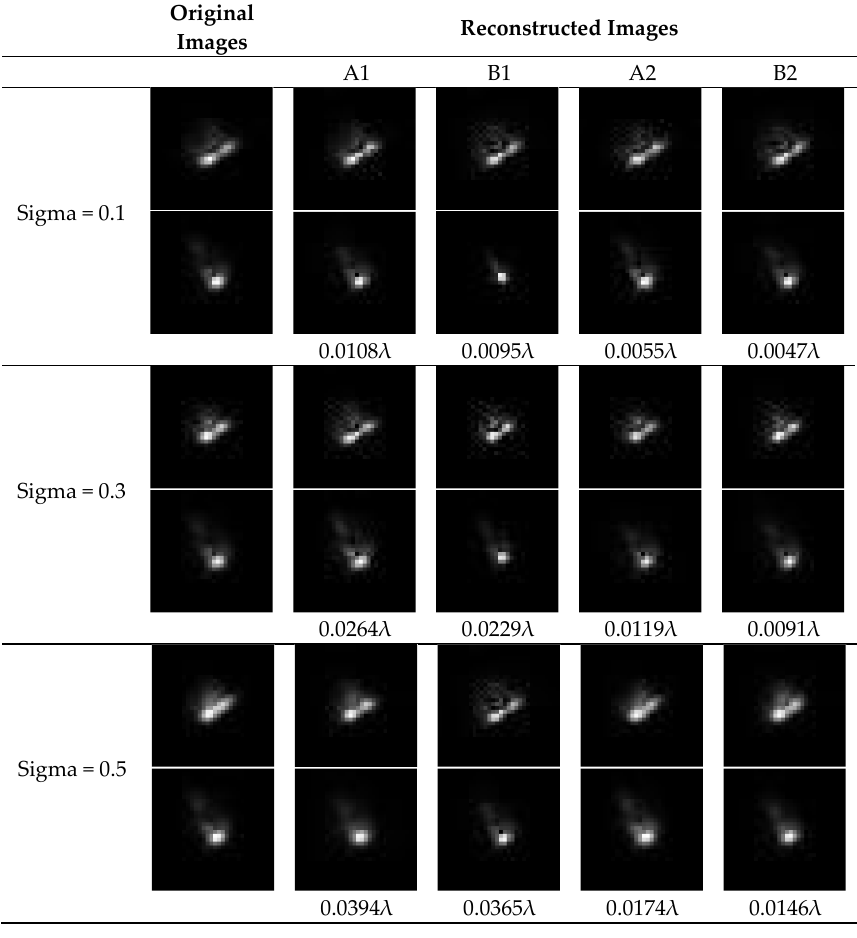
Figure 8. Results of the Traditional phase retrieval algorithms (A1, B1) and the jitter-robust phase retrieval algorithms (A2, B2) when they are applied to those images obtained in the experiment which include the effects of jitter.